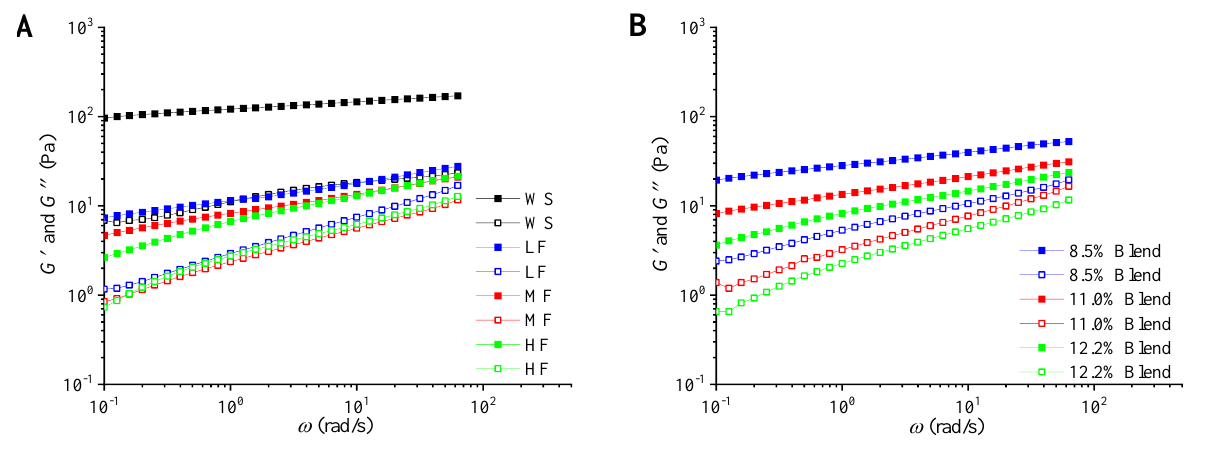
Figure 5. Storage modulus ( G′ , solid) and loss modulus ( G″ , hollow) as a function of frequency for the film-forming matrices at 25 °C: ( A ) pure WS, wheat flours with different protein contents (8.5%, 11.0%, and 12.2%), and ( B ) WS–gluten blends with different protein contents (8.5%, 11.0%, and 12.2%). Table 2. Values of n (cid:48) , n (cid:48)(cid:48) , G 0 (cid:48) , and G 0 (cid:48)(cid:48) for the film-forming matrices of pure WS, wheat flours, and WS–gluten blends with different gluten content (8.5%, 11.0%, and 12.2%) at 25 ◦ C.